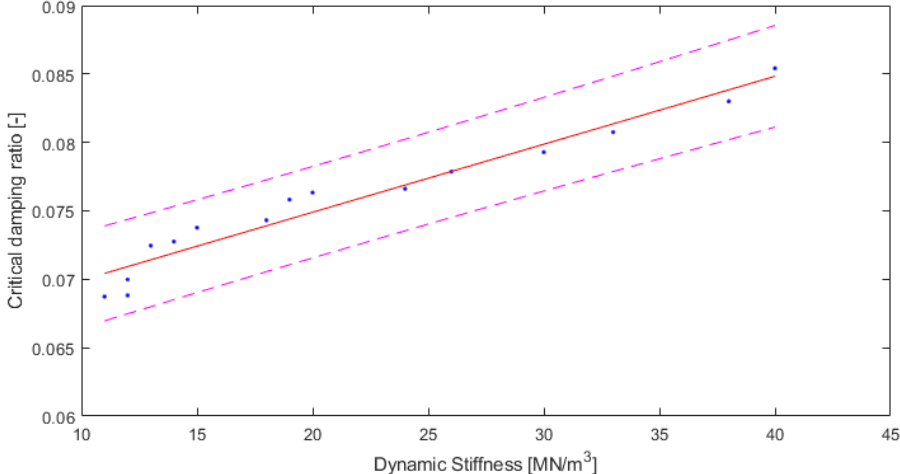
Figure 10. Results for critical damping ratio depending on dynamic stiffness of material, with 95% confidence bounds (own elaboration).